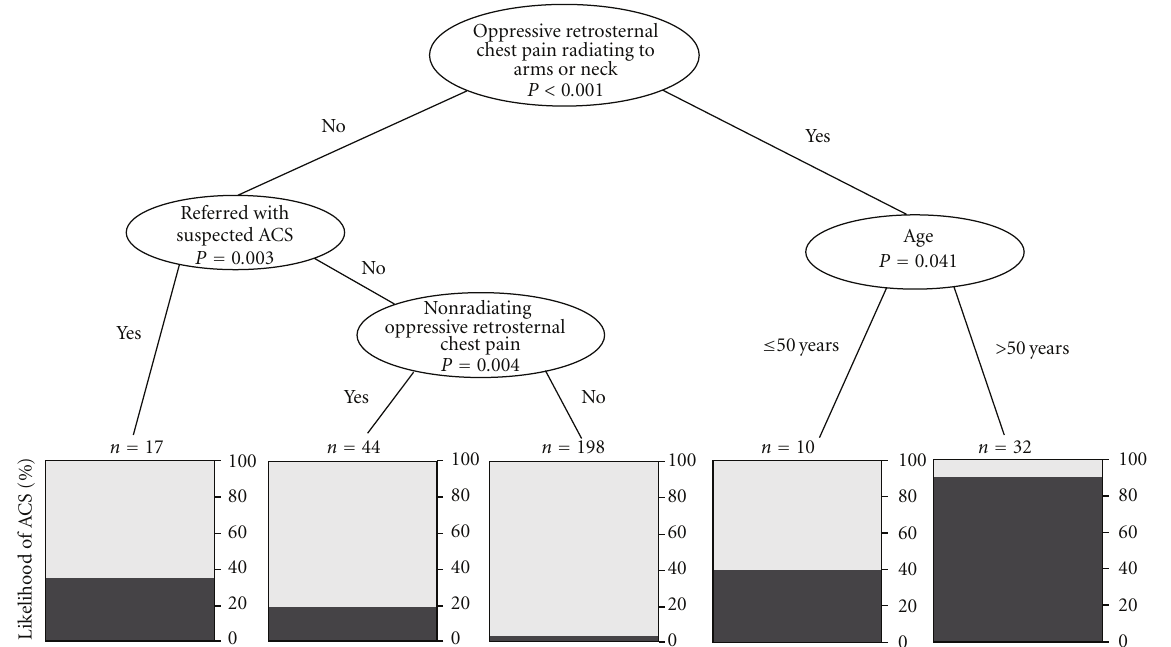
Figure 1: Conditional inference tree based on all clinical relevant variables associated with ACS: The boxes show the likelihood of ACS to be high (91%, n = 32), low (4%, n = 198), or intermediate (40%, n = 10, 35%, n = 17, and 20.5%, n =